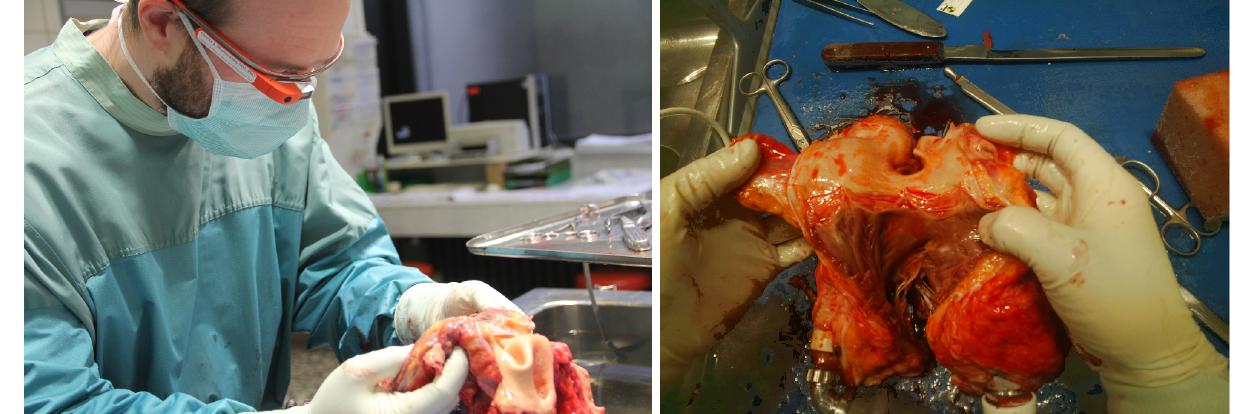
Figure 4. The forensic pathologist is taking a picture of the heart using Google Glass (left). The original image taken with the device allows viewers a first-person perspective of the structure